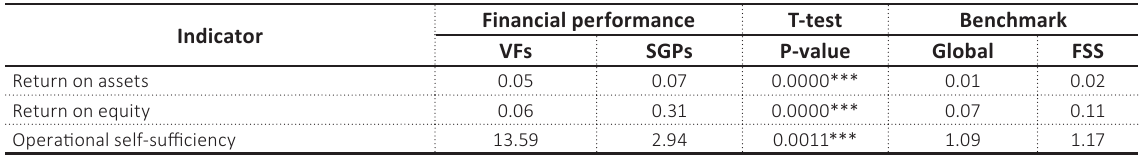
Table 4. A comparison of Thai MFIs’ financial performance (mean values from 2014 to